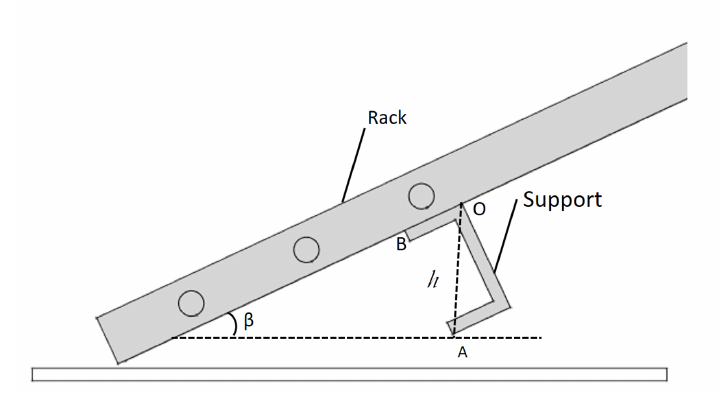
Figure 6. Vertical projection of the support to estimate the frontal